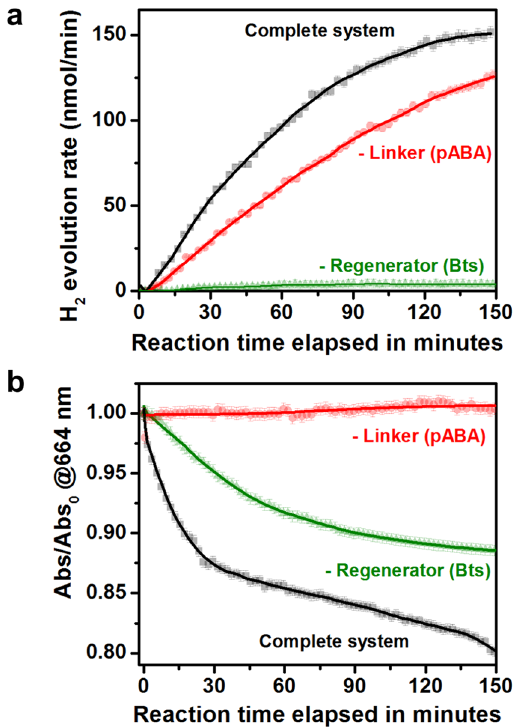
Figure 2. Effect of components in hydrogen production and methylene blue (MB + ) oxidation. ( a ) Hydrogen production and ( b ) methylene blue (MB + ) oxidation from the complete silver based nano-hybrid assembly (Bts-Ag NP–linker–TiO 2 –Ru NPs), without the regeneration layer (–Regenerator (Bts)) and without the molecular wire linker (–pABA), upon monochromatic excitation at 405